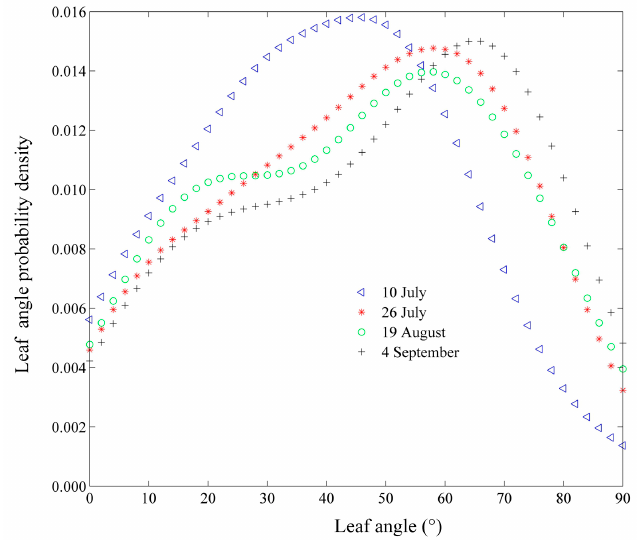
Figure 6. The leaf angle probability density functions for the corn canopy on 10 July, 26 July, 19 August, and 4 September, 2014, respectively. Figure 6 indicates that the leaf angle at the maximum probability density decreased when χ increased through time: the leaf angle intervals around the maximum probability density are from 40° to 50° on 10 July (the stem elongation stage), from 50° to 60° on 26 July (the heading stage) and on 19 August (the flowering stage), and from 60° to 70° on 4 September (the grain-filling stage). Thus, the dominant leaf angle increased over the course of the growing season. 3.3. Retrieved Corn Canopy LAIs LAI values at four phenological stages were retrieved through using the PROSAIL model based on the lookup table and the leaf angle function inferred from the terrestrial LiDAR data. Figure 7 shows maps of the retrieved LAI derived for the stem elongation stage (10 July), the heading stage (26 July), the flowering stage (19 August), and the grain-ripening stage (4 September). Figure 7a shows low LAI values during the early growing season (10 July, at the seven-leaf stage for corn in study area), with values ranging from 0.5 m 2 /m 2 to 2.7 m 2 /m 2 . By 26 July (heading stage; Figure 7b), LAI had increased to 3.7. By late August (flowering stage; Figure 7c), LAI reached values of up to 7.2. By early September (grain filling stage; Figure 7d), LAI reached its seasonal maximum, with values reaching up to 7.8. The retrieved LAI maps therefore show a realistic progression of LAI throughout the growing season. In order to validate these LAI retrieval results, a further assessment of the accuracy is completed. The extensive in-situ measured LAIs on 4 September are used to determine whether the introduction of inferred leaf angle distributions from TLS data points can improve the LAI retrieval accuracy using the PROSAIL model. In addition, the LAI retrieval results on 10 July, 26 July, 19 August and 4 September with default and inferred corn leaf angle distribution functions are all compared with MODIS LAI products in the whole study area. This comparison is done to evaluate the LAI retrieved results in a wide spatial range and temporal range. Figure 8 shows the relationships between the in-situ measured LAI and the retrieved LAIs using inferred and default leaf angle function for the retrieved results of 4 September. The results show a strong and significant